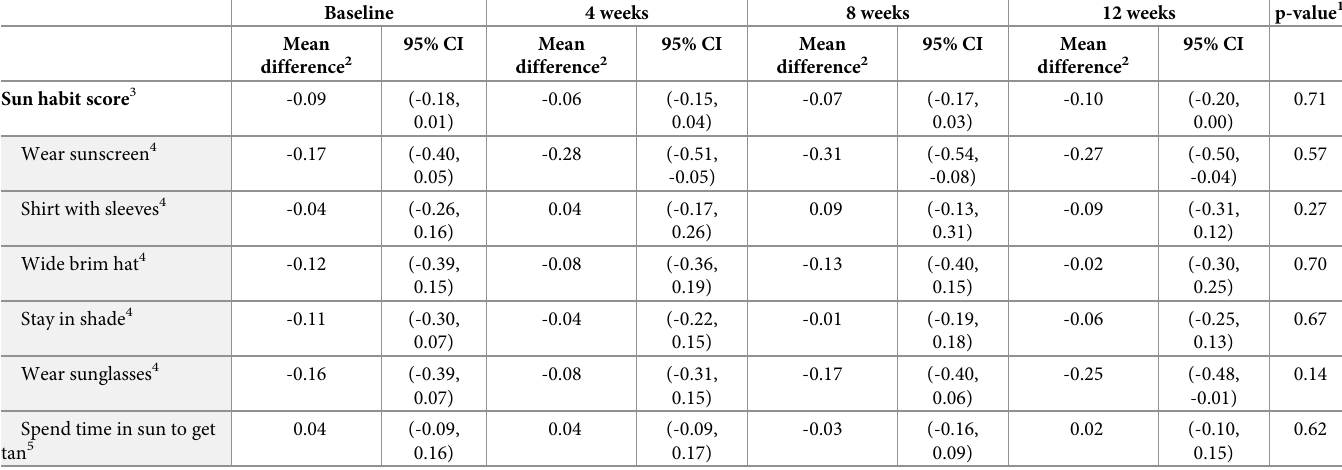
Table 2. Differences in least square (LS) means for sun protection scores at baseline and during the intervention period between the intervention and control